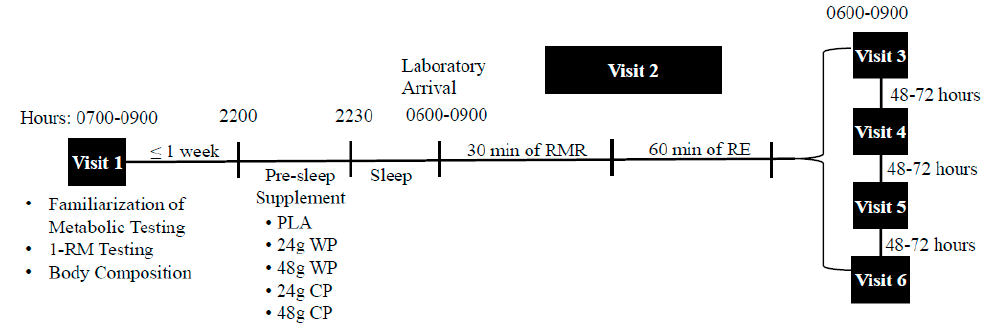
Figure 1. Study Timeline. 1-RM, one-repetition strength testing; RMR, resting metabolic rate measurements; the morning after pre-sleep consumption of a single serving of 24 or 48 g whey protein (WP), 24 or 28 g casein protein (CP), and a non-energetic placebo (PLA).